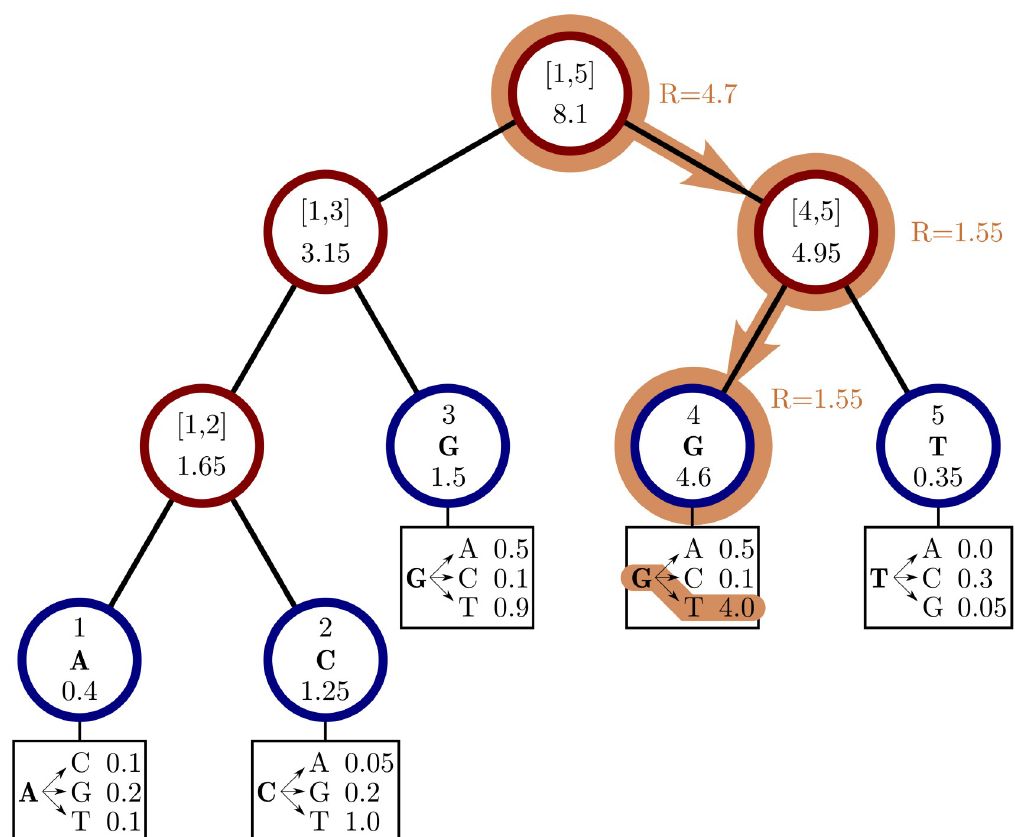
Fig 1. Example genome search tree and its use. An example genome search tree for ancestral genome ACGGT. Blue nodes are terminal and red nodes are internal. Inside each node we represent on top the genome positions represented by the node; at the center inside terminal nodes we show the allele of the node; at the bottom of nodes is their total rate. Under each terminal node we show the example relevant mutation rates. The path highlighted in orange shows an example sampling of one mutation event. A parameter R is assigned an initial random number sampled uniformly between 0 and the total rate 8.1, in this case it is R = 4.7. As we move downward, the value of R can decrease, as described in Algorithm 2, determining which site will mutate and how. Here, an initial R = 4.7 results in the sampling of a G ! T mutation at genome position 4.